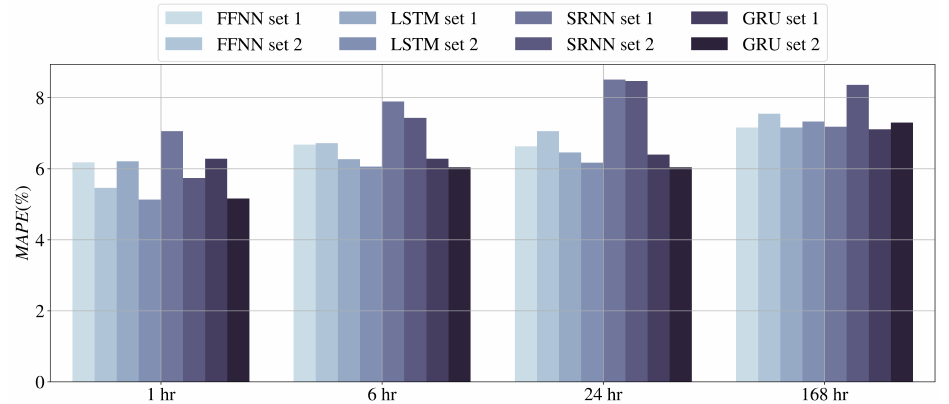
Figure 9. MAPE (%) of the best ANN models on the 4 forecasting horizons (x-axis) with two sets of inputs: set 1 (smaller number of lags) and set 2 (larger number of